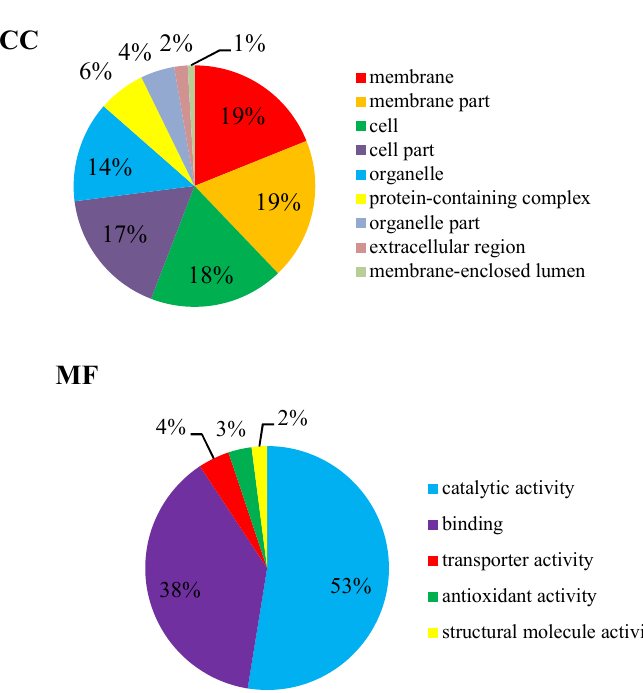
Figure 7. GO annotation for the DEPs.